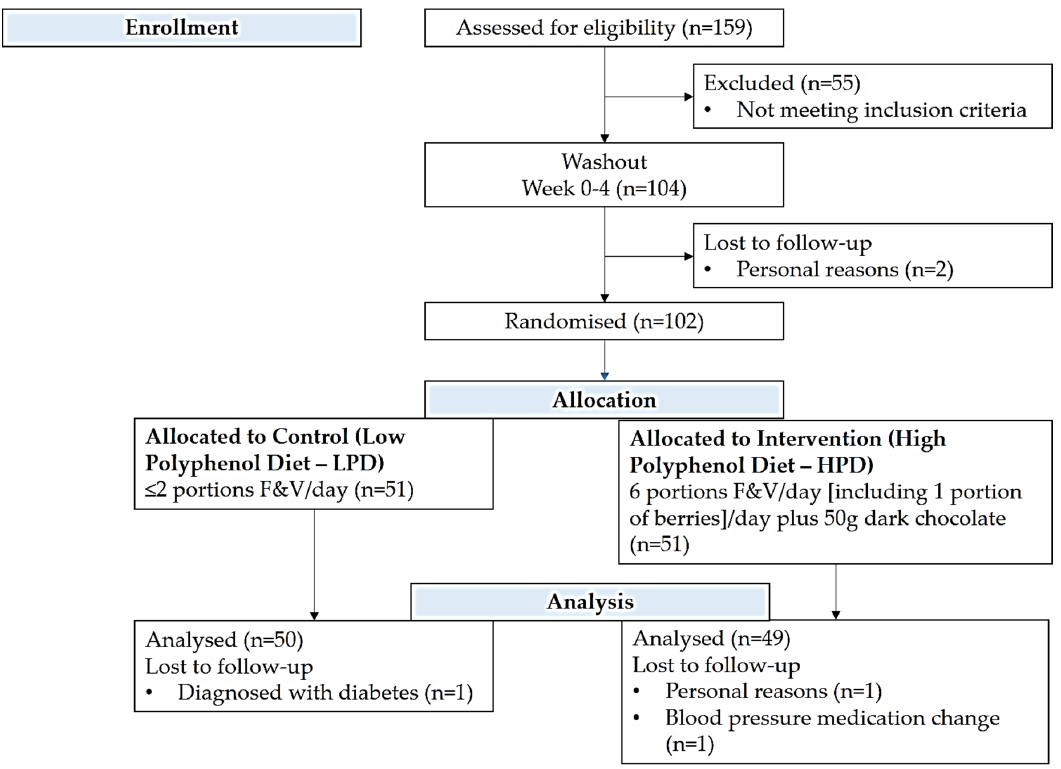
Figure 1. CONSORT diagram summarizing flow of participants through the study.